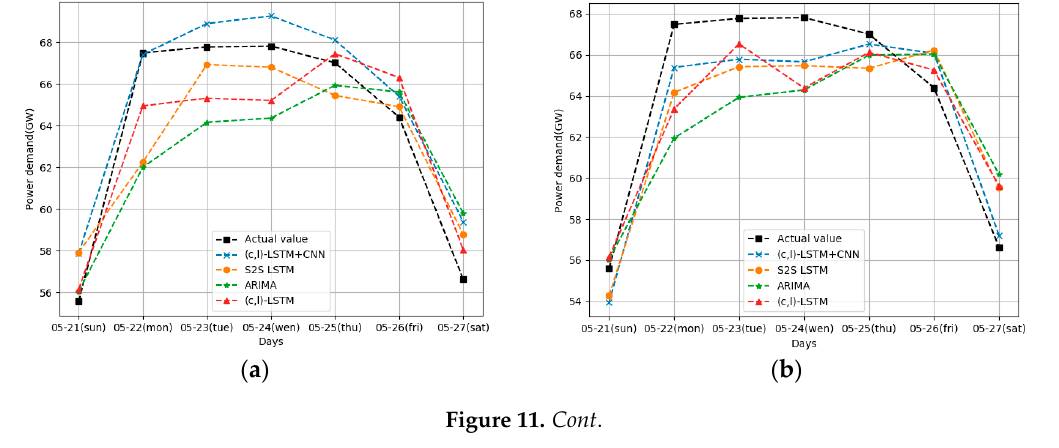
Figure 10. Forecasting performances on d 3 .